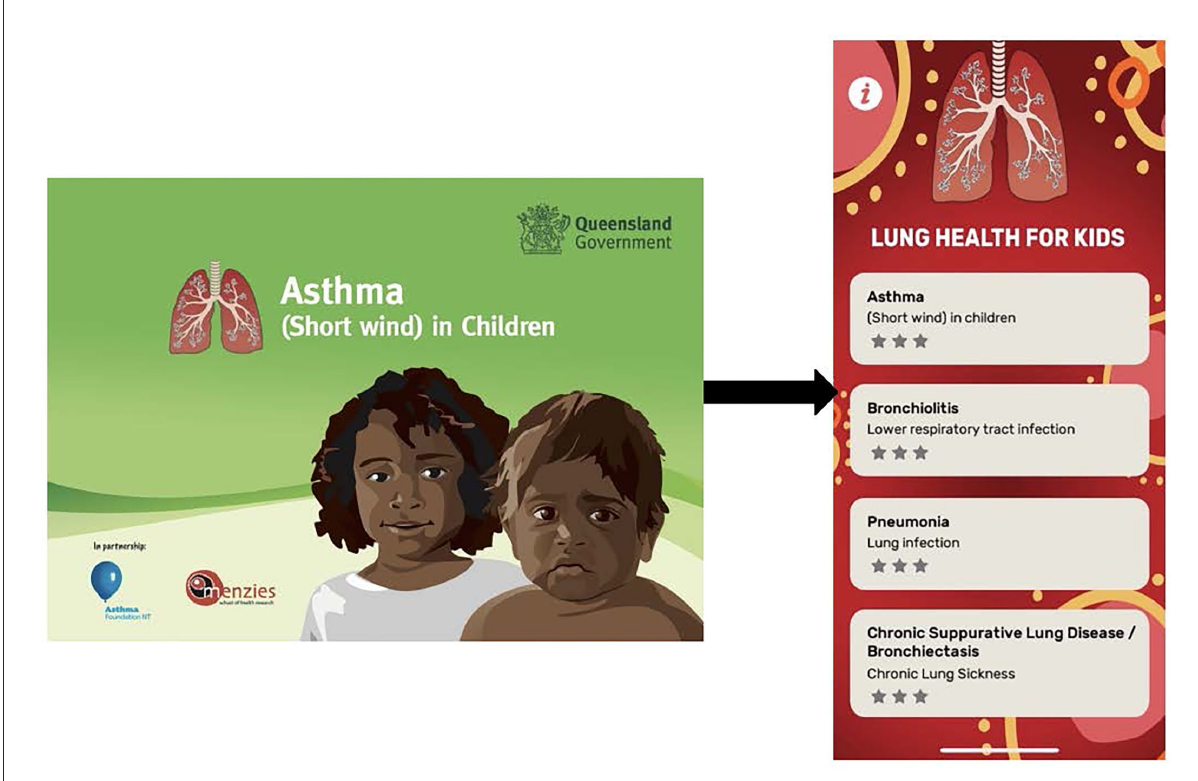
FIGURE1 Transition from paper-based asthma flipchart to the “Lung Health for Kids